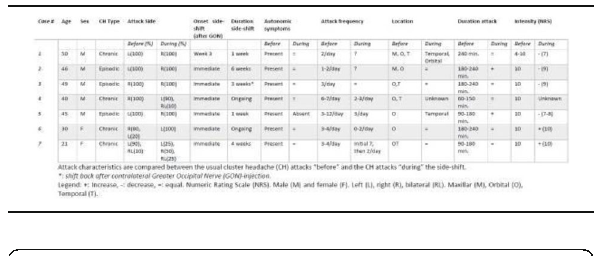
Table 1 (abstract P18). Patient and side-shift characteristics